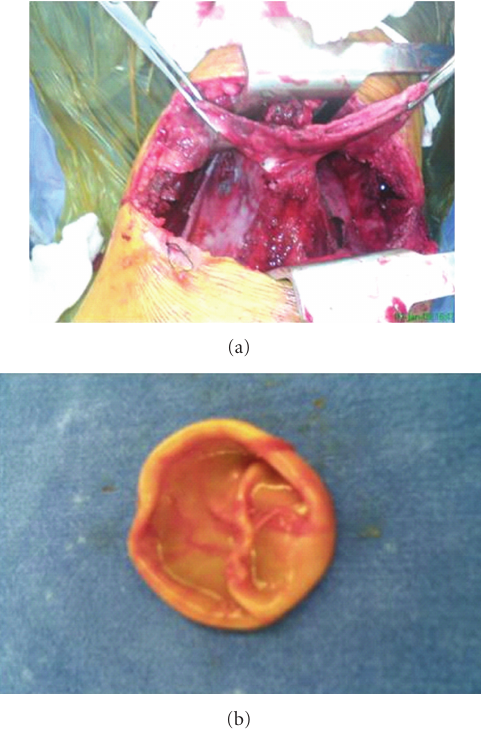
Figure 3: (a) Collapsed left lung with pleural thickening and adhesions and massive air leak preventing expansion. (b) Ruptured endocyst found adherent to left upper lobe.